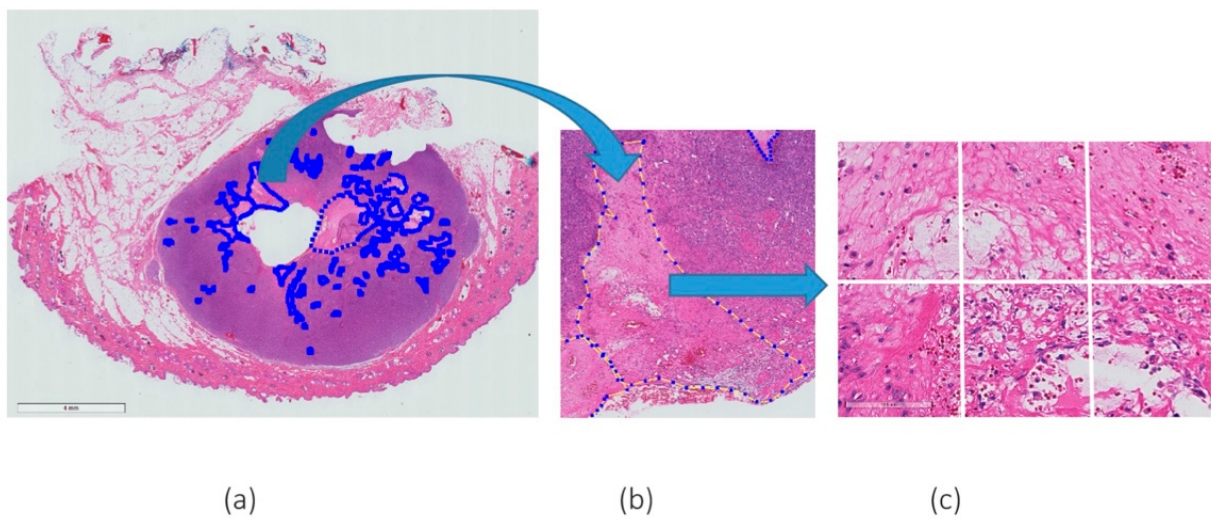
Figure 1. Example of H&E WSI with ( a ) a few annotations of necrosis marked by expert pathologists, ( b ) a magnified (magnification 5×) region of agreement of both pathologists and ( c ) an example of patches extracted from the annotated region (magnification 20×).